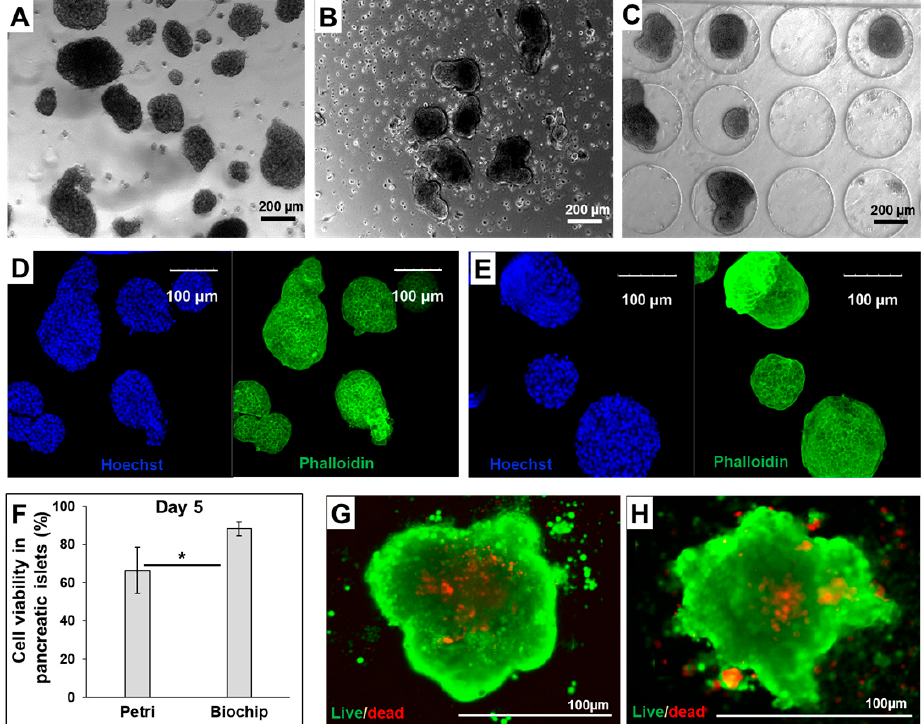
Figure 1. Islet morphology and viability. ( A – C ) morphology of the islets after extraction, after 5 days of culture in Petri and after 5 days of culture in biochip, respectively; ( D , E ) Hoechst (nuclei, blue) and phalloidin (F-actin, green) staining of islets cultured in Petri and biochip, respectively; ( F ) cell viability in pancreatic islets at the end of the experiment (day 5); ( G , H ) live/dead staining at the end of the experiment (day 5) for islets cultured in Petri and biochip, respectively; calcein (living cells, green) and propidium iodide (dead cells, red). * p < 0.05.